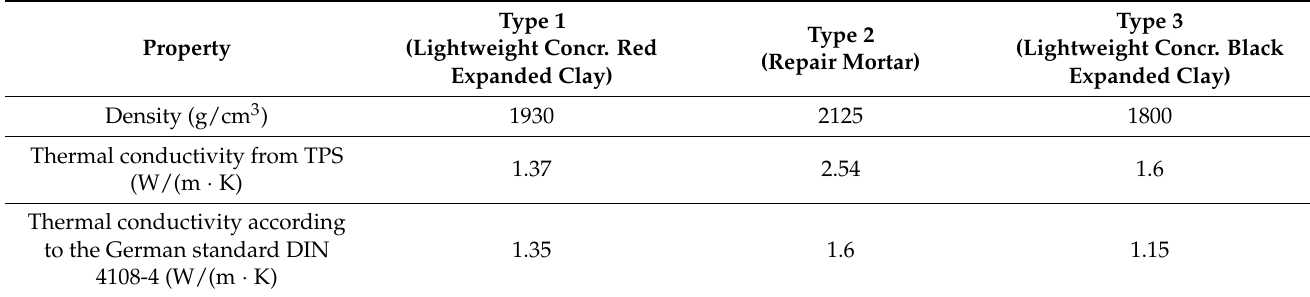
Table 2. Density and thermal conductivity of the investigated concrete samples .